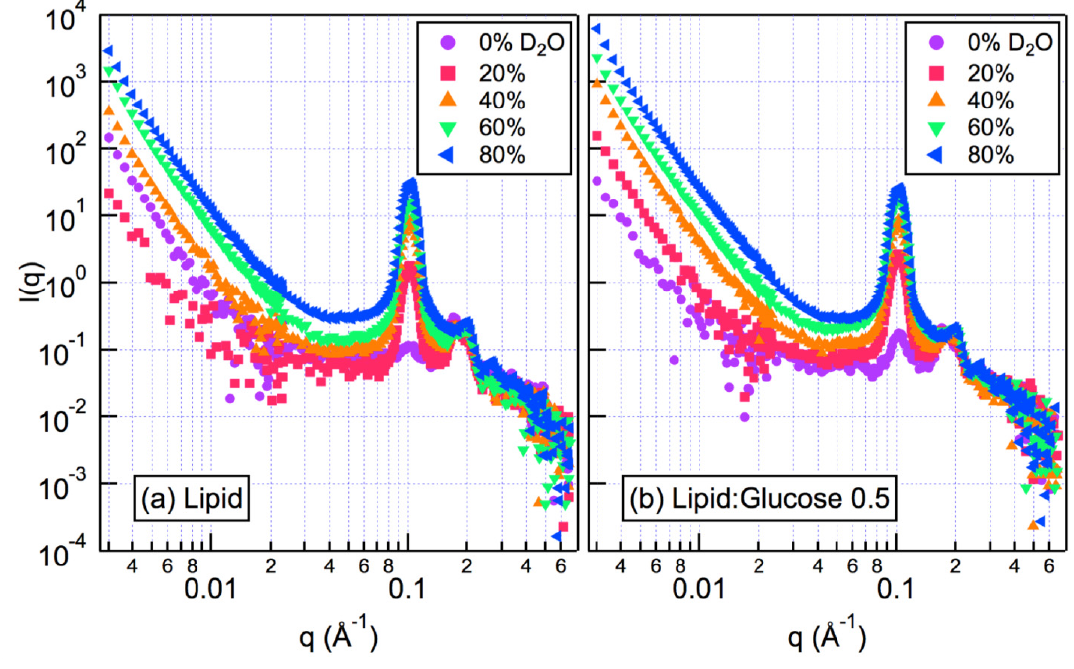
O. The data show the typical form 2 phase at s higher q II